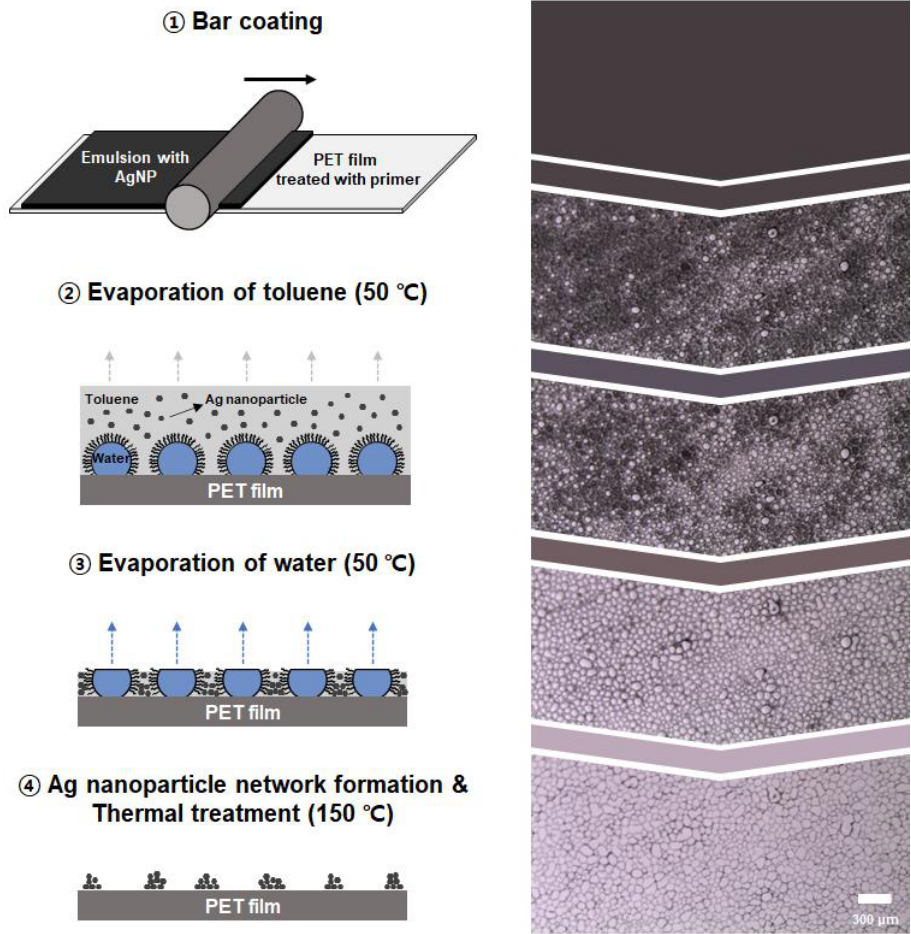
Figure 1. Schematic illustration for manufacturing TCFs and stepwise top-view images of the emul- sions.